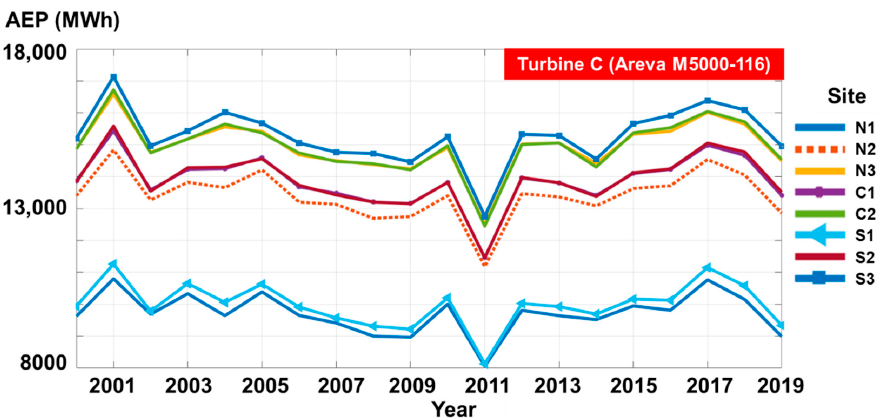
Figure 11. Annual distribution of the Annual Electricity Production (AEP) values associated with Turbine C (Areva M5000-116).